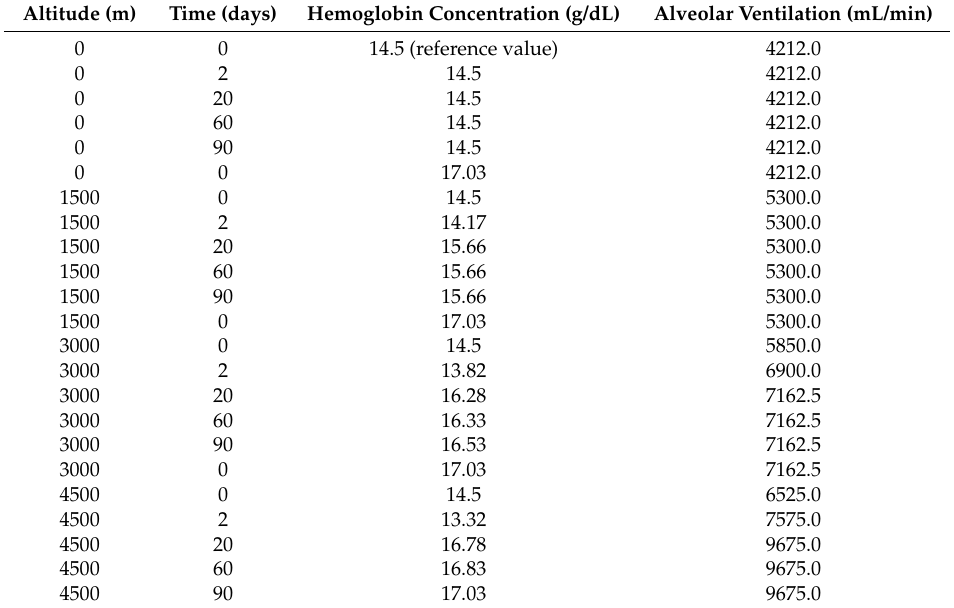
Table 4. Concentration of hemoglobin in the blood as function of time and altitude. Based on and adapted from